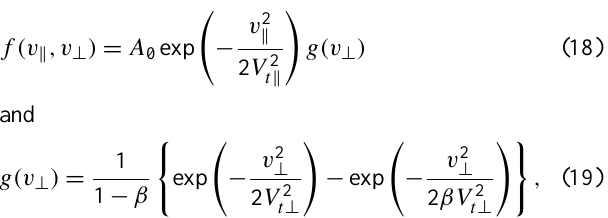
Fig. 3. Distribution of W int in velocity space computed at h = + 200 c(cid:127) − 1 over the time interval from 0 to 20000 (cid:127) − 1 e0 lines denote resonance ellipses of forward propagating whistler- mode waves of ω = 0 . 1, 0.2, 0.3, 0.4, 0.5, and 0.6 (cid:127) e0 (after Sum- mers et al., 1998). Coloured rectangles represent the energy and pitch angle ranges of Regions A, B, and C given in Table 1.